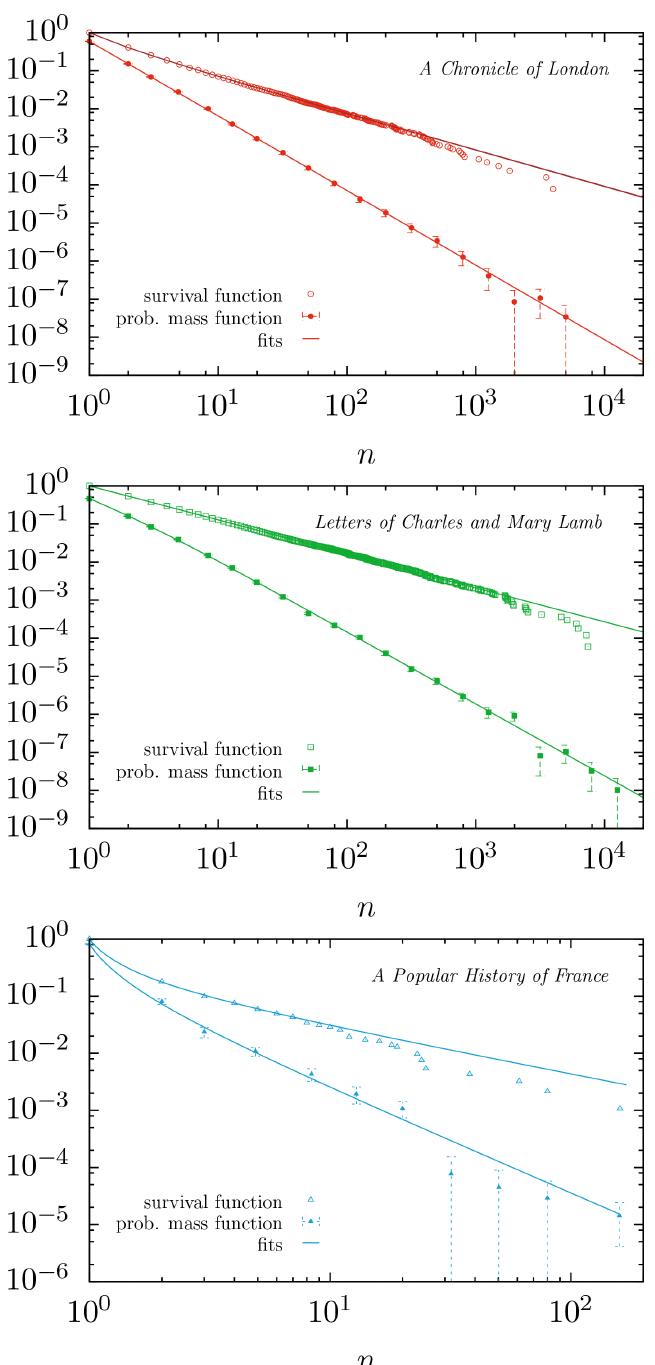
Fig 4. Complementary cumulative distribution and probability mass function of text frequencies, for: (a) A Chronicle of London, from 1089 to 1483 (anonymous); (b) The Works of Charles and Mary Lamb , Vol. V, edited by E. V. Lucas; (c) A Popular History of France from the Earliest Times , Vol. I, by F. Guizot. These texts are the ones with the largest length L (83 720, 239 018 and 2 081 respectively) of those that fulfill p > 1/2, for fits 1, 2 and 3 respectively. The exponent β takes values 1.96, 1.89, and 1.82, in each